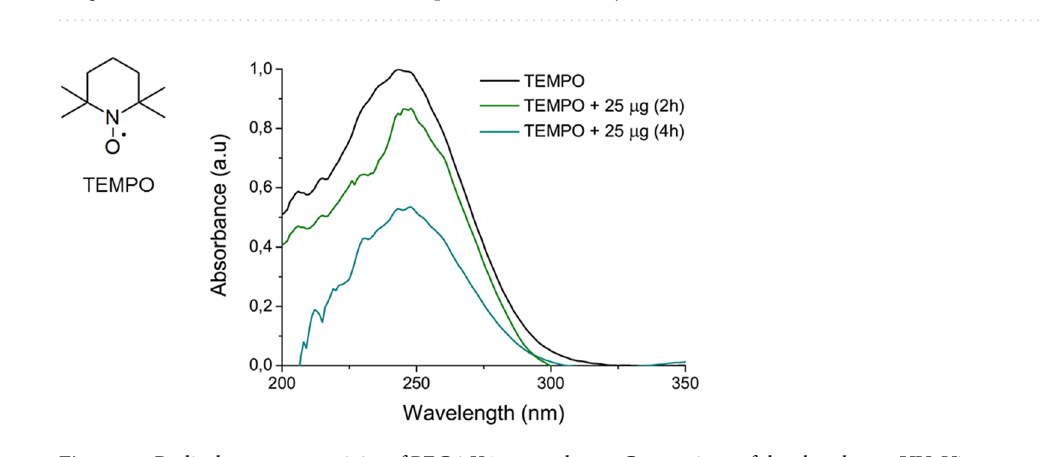
Figure 5. Radical scavenger activity of PEG6-Y4 nanospheres. Comparison of the absorbance UV–Vis spectrum of TEMPO alone and coincubated for 30 min with 25 µg of PEG6-Y4 heated for 2 or 4